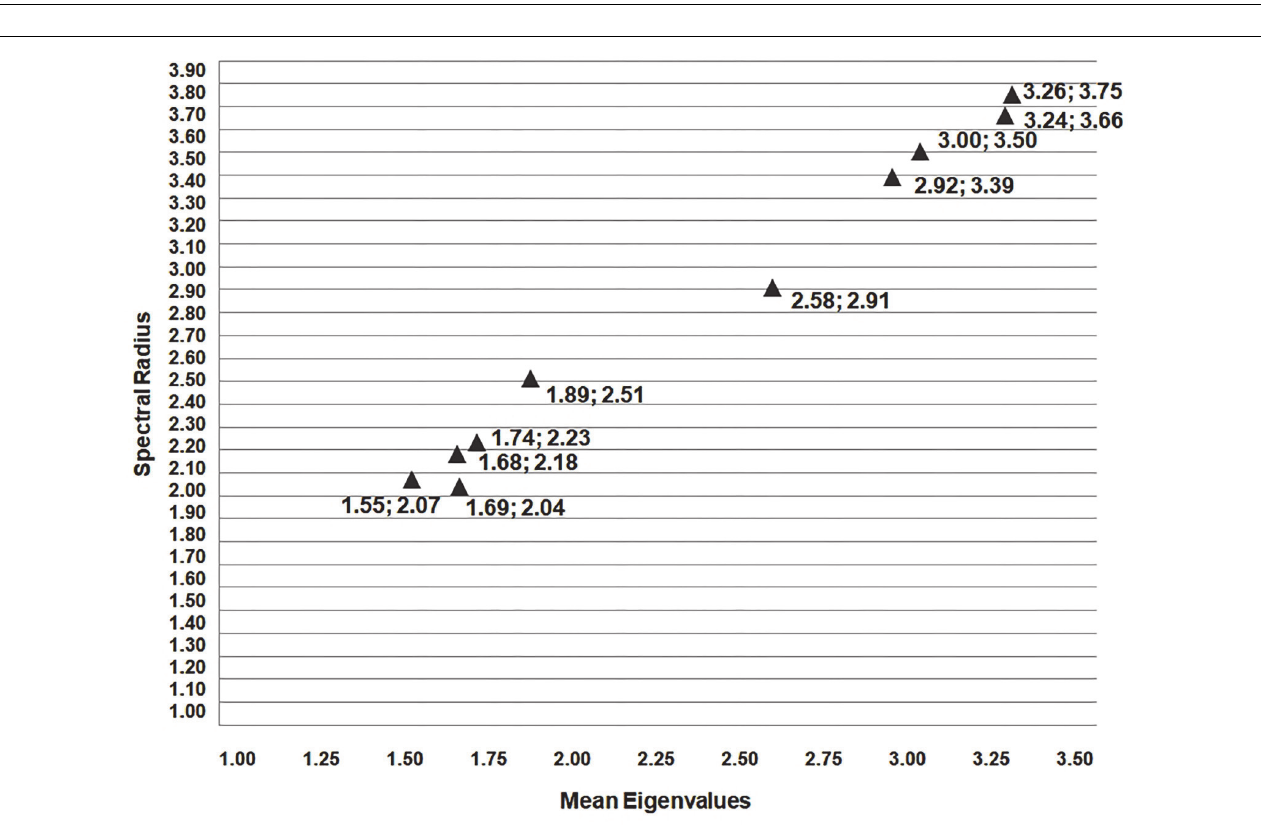
FIGURE 4 | The SR results ( y -axis) by Olympic edition versus mean eigenvalues ( x -axis) represented by the triangle with the coordinates ( x ; y ). It is important to note that the Medalists SR results were always above 2.91 and the non-medalists’ results are under 2.51. This point to a common behavior among Medalists-Winners (highest values) at all 5 editions of the games analyzed, with significant differences (One-way ANOVA followed by Tukey HSD post hoc test, p < 0.05).